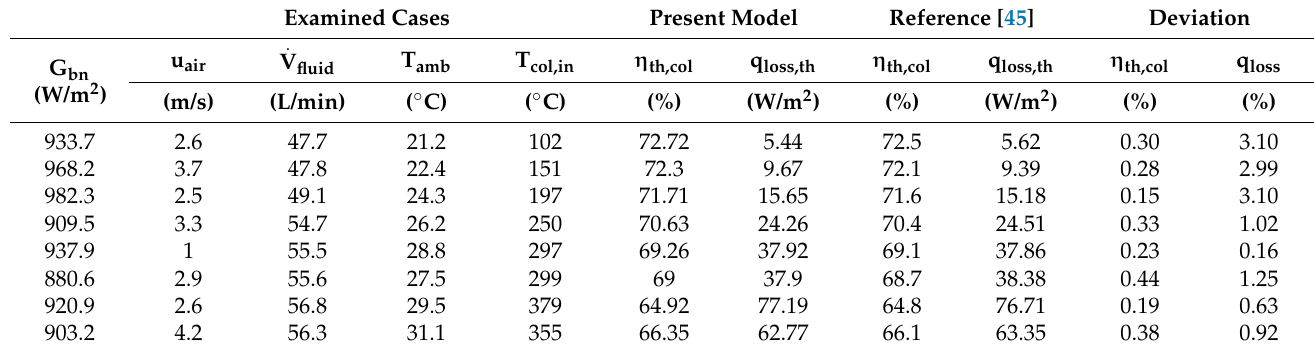
Table 4. Validation of the PTC with experimental data from the literature.